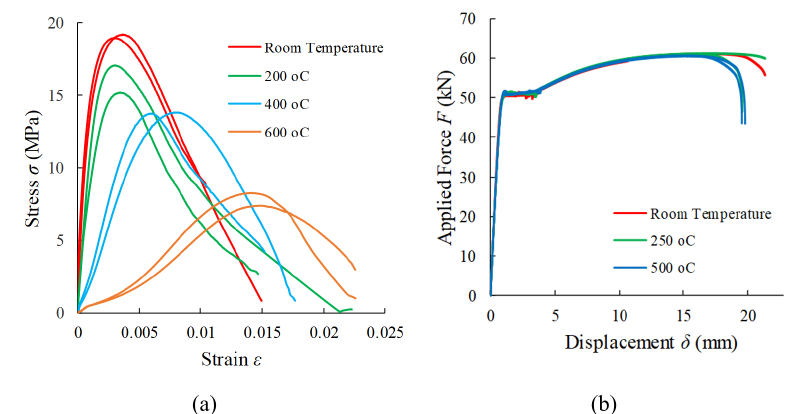
Figure 5. Response of materials after exposure to different temperatures: a) stress-strain relations for plain concrete; b) force- displacement curves for